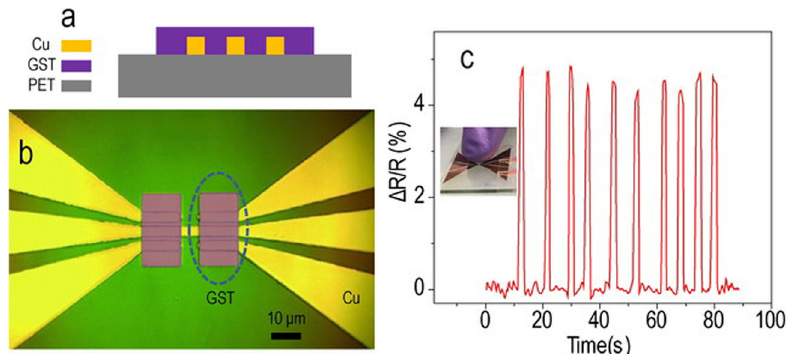
Fig. 6 a Cross-sectional schematic of the GST sensor. b Optical microscopy image of the fl exible strain sensor with 1 μ m GST gap (scale bar, 10 μ m). c Relative resistance change with touching